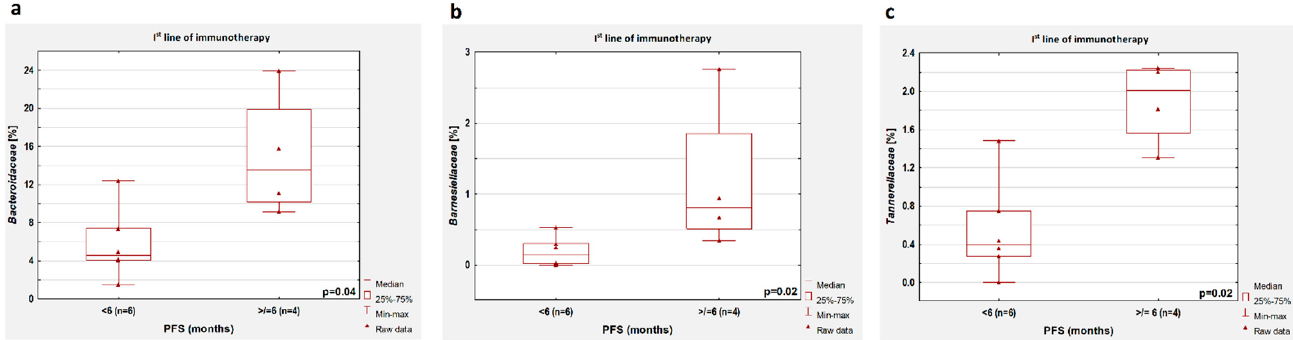
Figure 6. Differences in the abundance of individual bacteria in patients with PFS shorter and longer than 6 months. Boxplots showing the content of ( a ) Bacteroidaaceae , ( b ) Barnesiellaceae, and ( c ) Tannerellaceae in the group of patients treated with first-line immunotherapy.